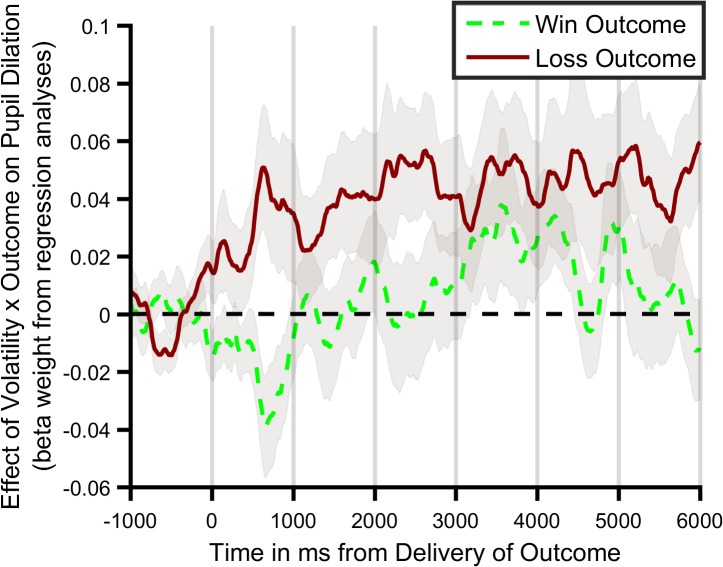
Regression analysis of pupil data.The analysis of pupil data reported in the main text examines the effect of block information content (i.e. win volatile vs. loss volatile) and outcome receipt on the pupil response to win and loss outcomes. However a number of other factors may also influence pupil dilation such as the order in which the outcomes were presented and the surprise associated with the outcome (Browning et al., 2015). In order to ensure that these additional factors could not account for our findings we ran a regression analysis of the pupil data from the learning task. In this analysis we derived, for each participant, trialwise estimates of the outcome volatility and outcome surprise of the chosen option using the Ideal Bayesian Observer reported by Behrens et al. (Behrens et al., 2007). These estimates were entered as explanatory variables alongside variables coding for outcome order (i.e. win displayed first or second), outcome of the trial (outcome received or not) and an additional term coding for the interaction between the outcome volatility and outcome of the trial (i.e. analogous to the pupil effect reported in Figure 3). Separate regression analyses were run for each 2 ms timepoint across the outcome period, for win and loss outcomes and for each participant. This resulted in timeseries of beta weights representing the impact of each explanatory factor, for each participant and for win and loss outcomes. As can be seen, consistent with the results reported in the paper this analysis revealed a significant volatility x outcome interaction for loss outcomes (F(1,27)=6.249, p=0.019), with no effect for wins (F(1,27)=0.215, p=0.646). This result indicates that the pupil effects reported in the main paper are not the result of outcome order or surprise effects on pupil dilation. Lines illustrates mean (SEM) beta weight of the volatility x outcome regressors for win (green) and loss (red) outcomes.